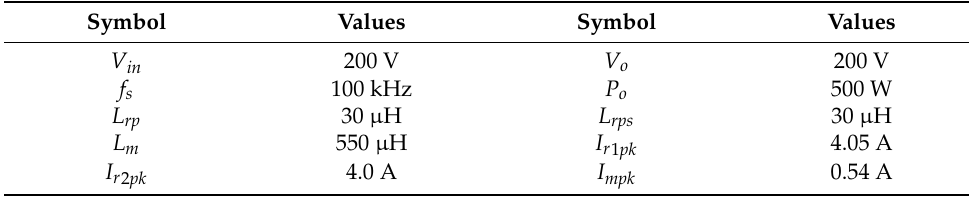
Table 3. The Parameters of the CLLC resonant converter and the current excitations. Symbol Values Symbol Values V in 200 V